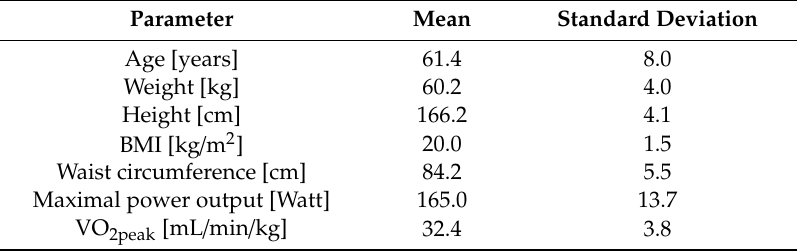
Table 1. Participant